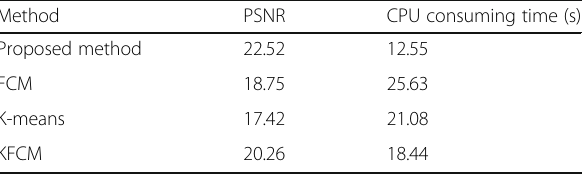
Table 3 Performance evaluation of different methods